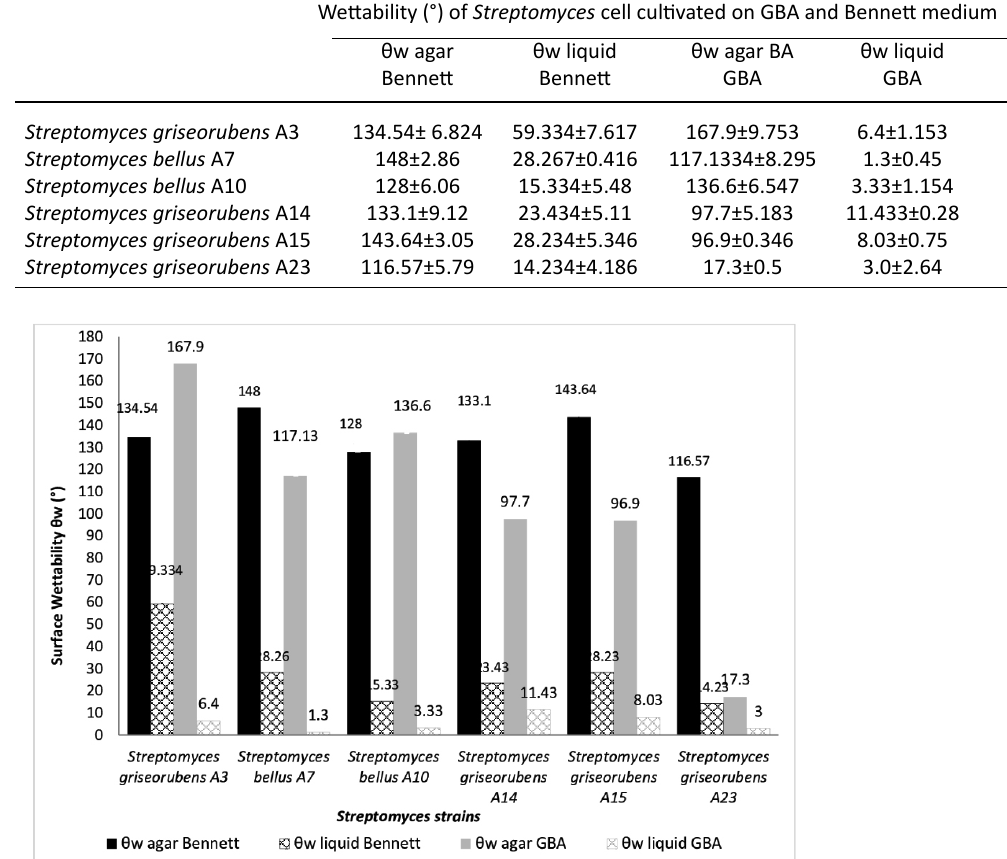
Table 2. Wettability of Six Streptomyces strains (in degree),grown in Bennett liquid, agar Bennett, GBA liquid, and